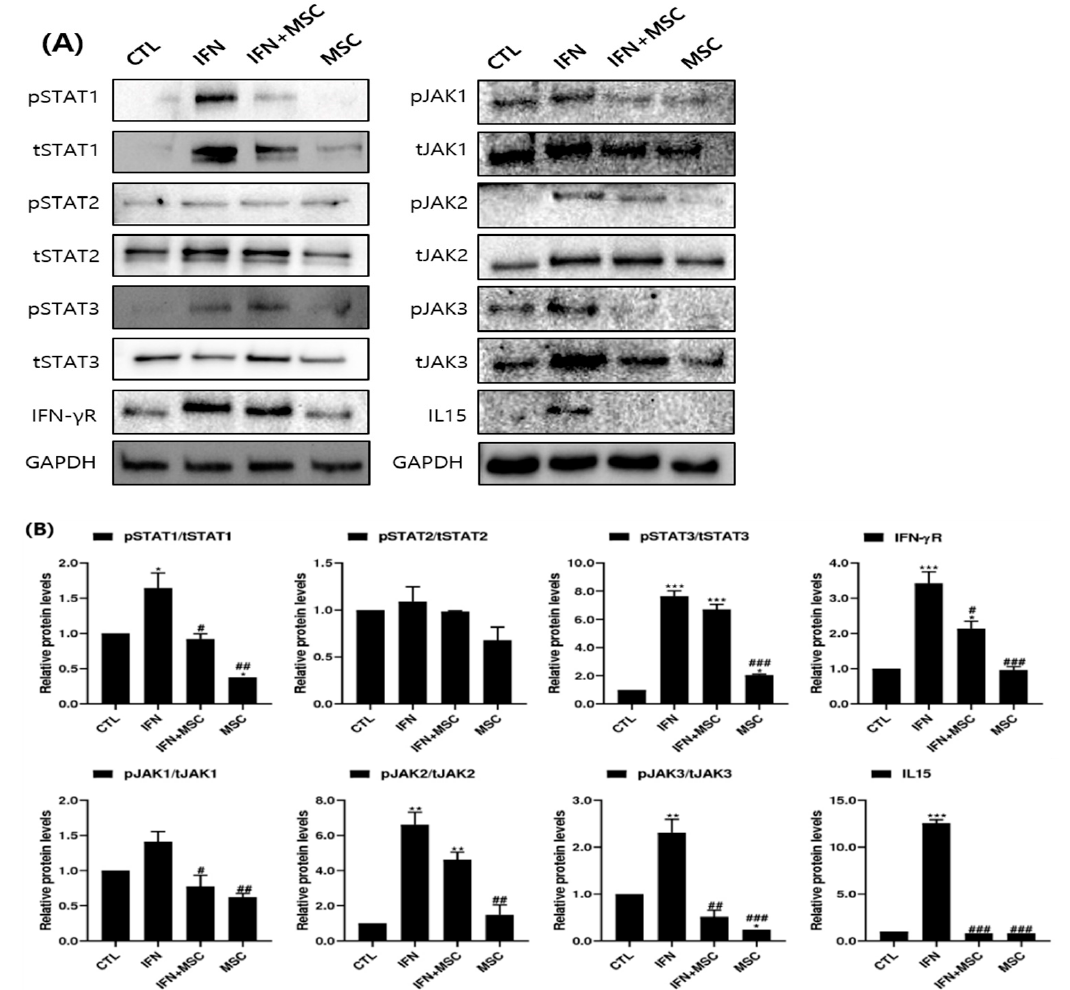
Figure 7. Analysis of JAK/STAT pathway-related marker protein levels induced by IFN- γ and MSCT. ( A ) Western blotting band images and ( B ) graphs of Western blotting band quantitation. The expression levels of JAK/STAT pathway molecules were assessed by Western blotting. GAPDH was used as a loading control. Overall, the expression of proteins in the IFN- γ -treated group was upregulated compared to the controls and downregulated by MSCT. Error bars represent the mean ± SEM, n = 3. Statistically significant at * p < 0.05, ** p < 0.01, and *** p < 0.001 compared to the control and # p < 0.05, ## p < 0.01, and ### p < 0.001 compared to the IFN- γ -treated